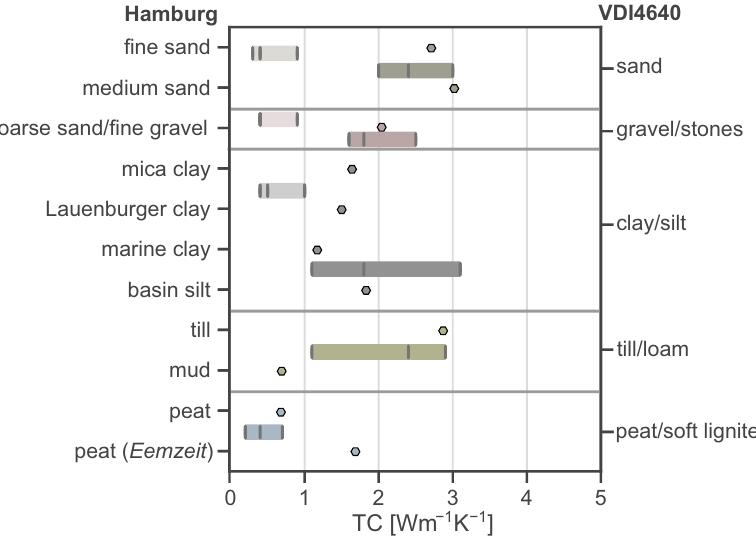
Figure 9. Comparison of laboratory measured thermal conductivity values in the Hamburg area [50] (dots) and corresponding min.-mean-max. ranges (bars) for both water-saturated (bright colors) and dry (pale colors) conditions from the VDI 4640 [37]. For till and peat, the VDI does not distinguish between saturated and dry